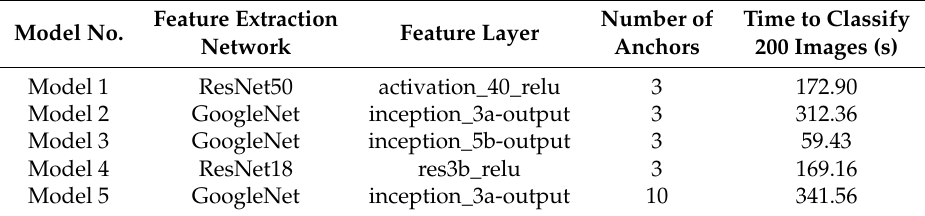
Table 2. Details of the five implemented classification